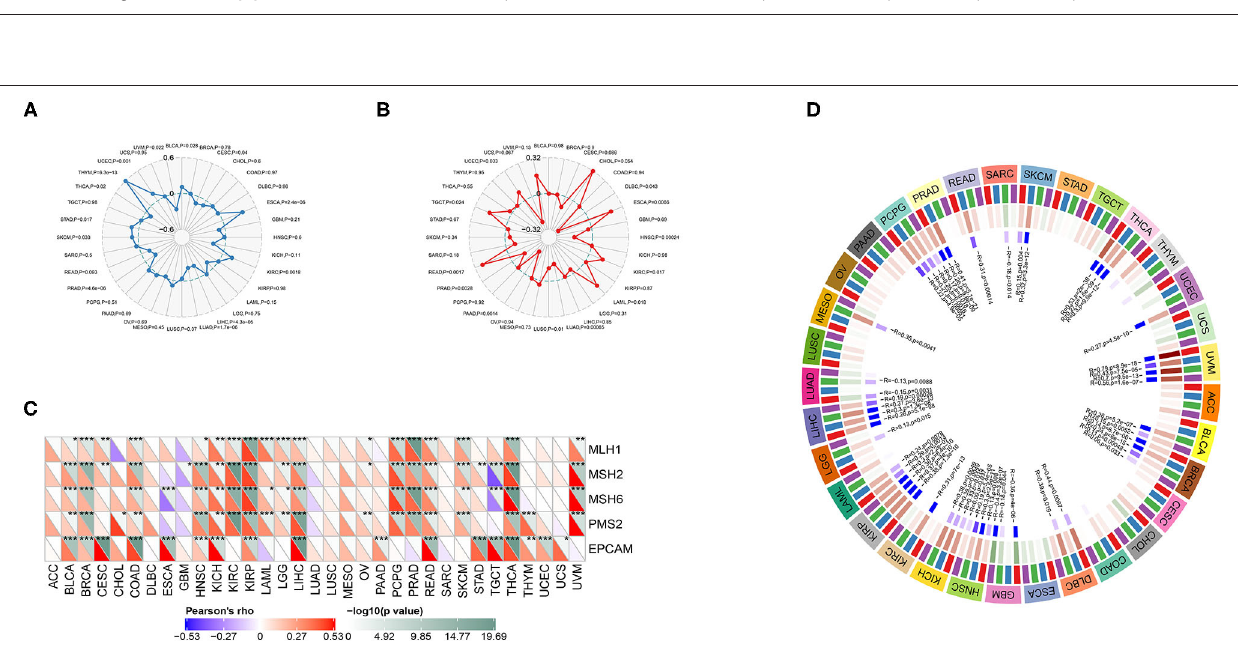
Frontiers in Cardiovascular Medicine | www.frontiersin.org